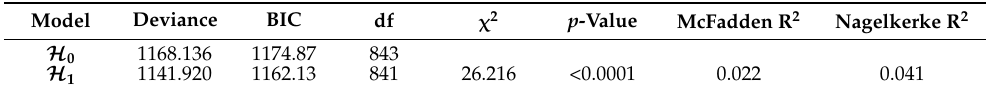
With lower BIC (Bayesian Information Criterion) scores, the summaries of the first two models show that H 1 suggests a significant relationship ( χ 2 (841) = 26.216, p < 0.0001) and ( χ 2 (128) = 33.382, p < 0.0001) successively for both models (Tables 5 and 6). Table 5. Summary of the logistic model characterizing the relationship between the variable Y 1 : “Have you been infected with COVID-19?” and the variables X 1 and Z 1 (Model 1). Model